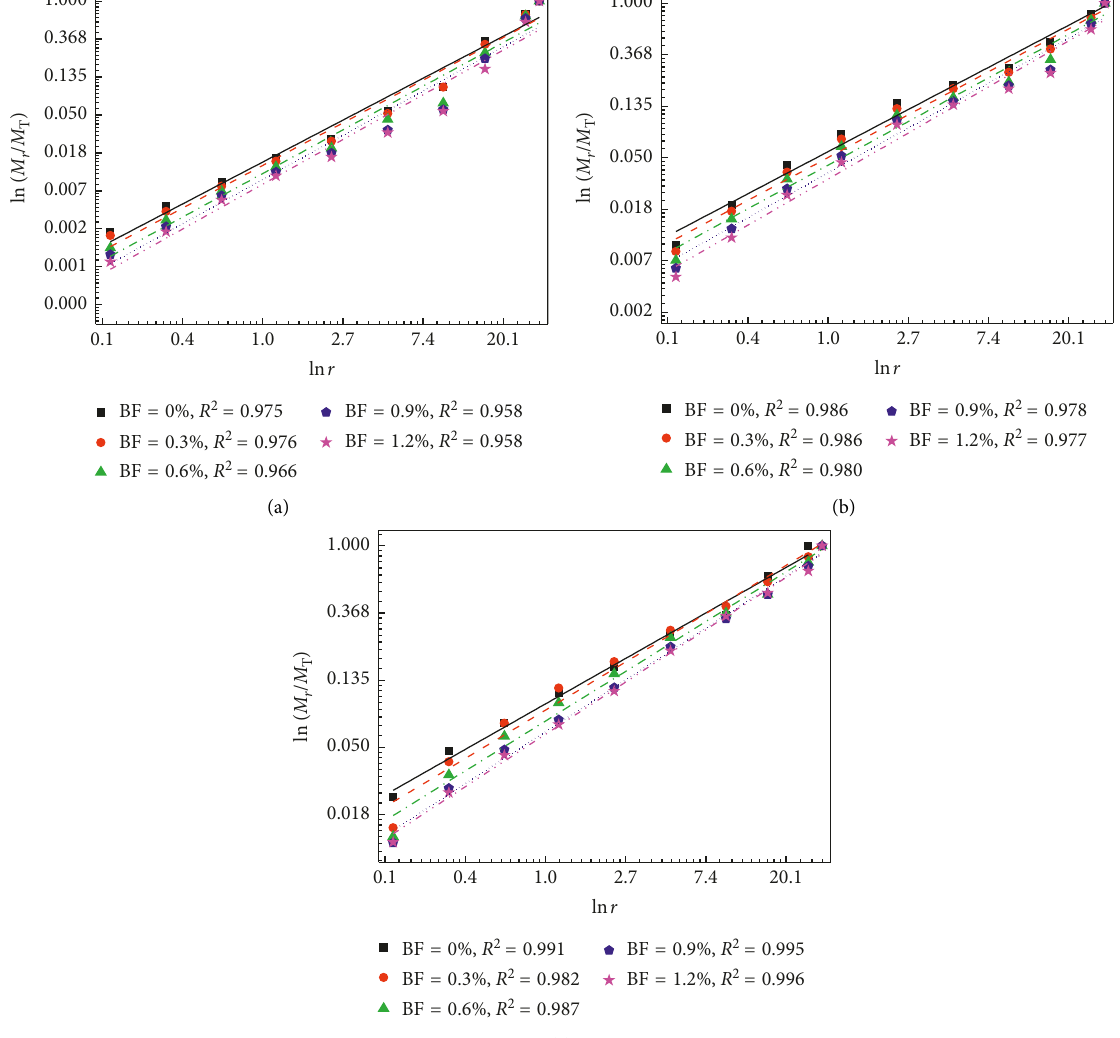
M ) -ln r curves. (a) 0.3MPa impact loading pressure. (b) 0.4MPa impact loading pressure. (c) 0.5MPa r / T